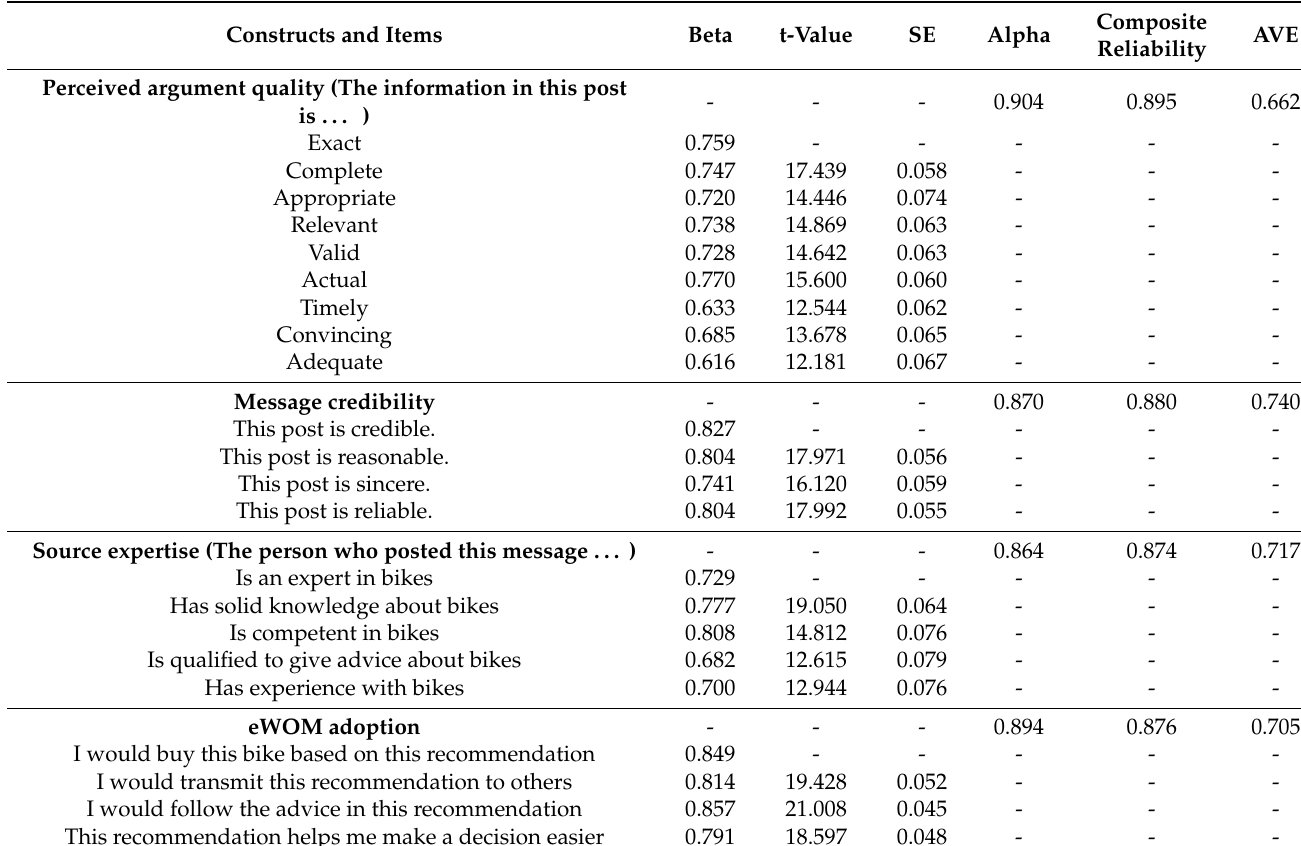
Table 1. Constructs and items.